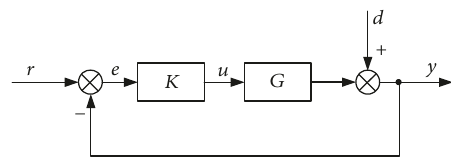
Figure 4: Suppression of output disturbance d .